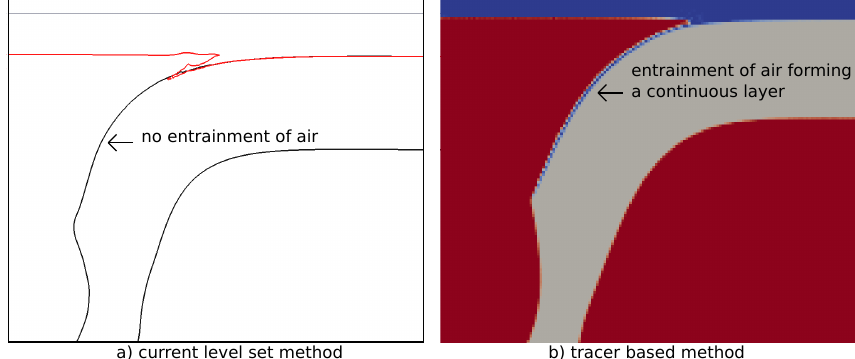
Figure 7. Comparison of the entrainment of air between a tracer-based method (ELEFANT) and our level set method.